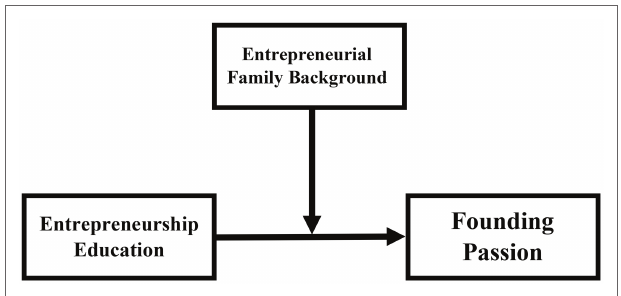
FIGURE 1 | The conceptual